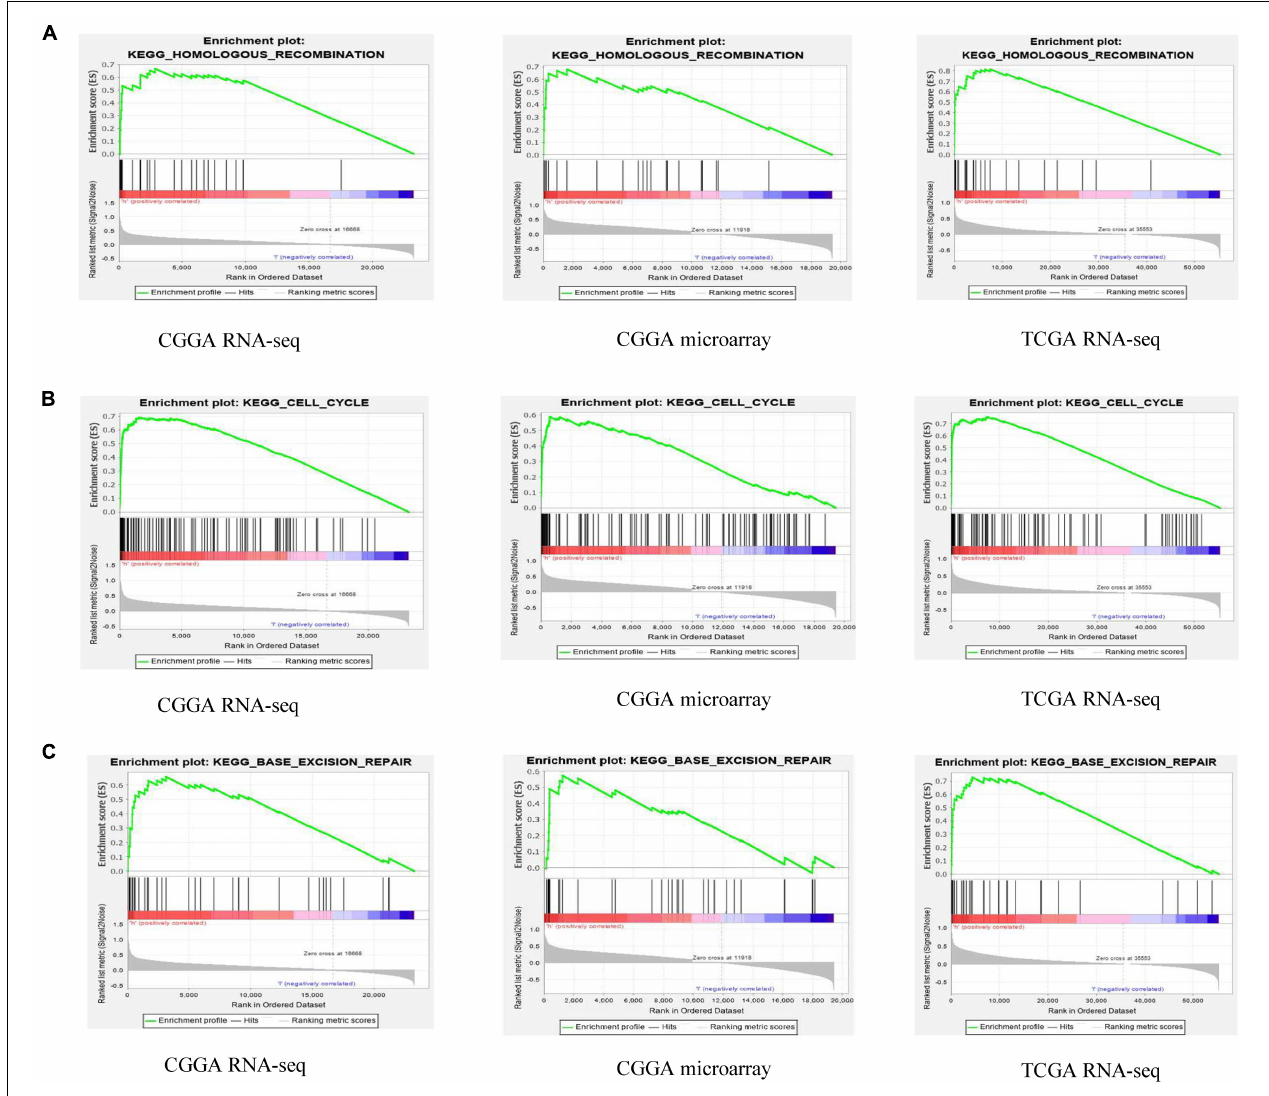
FIGURE 6 | Gene set enrichment analysis (GSEA) of ESPL1 in CGGA RNA-seq, CGGA microarray, and TCGA RNA-seq databases. The results of the three databases show that ESPL1 is associated with three pathways (A–C) homologous recombination, cell cycle, and base excision repair.